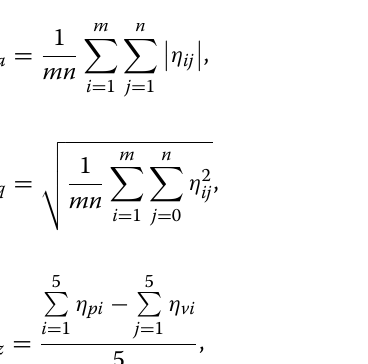
Table 5 Measurement data of machined surface roughness ( v Cutting parameters Average deviation of surface arithmetic( S a ) Surface root mean square deviation ( S q ) Surface ten-point average deviation ( S z